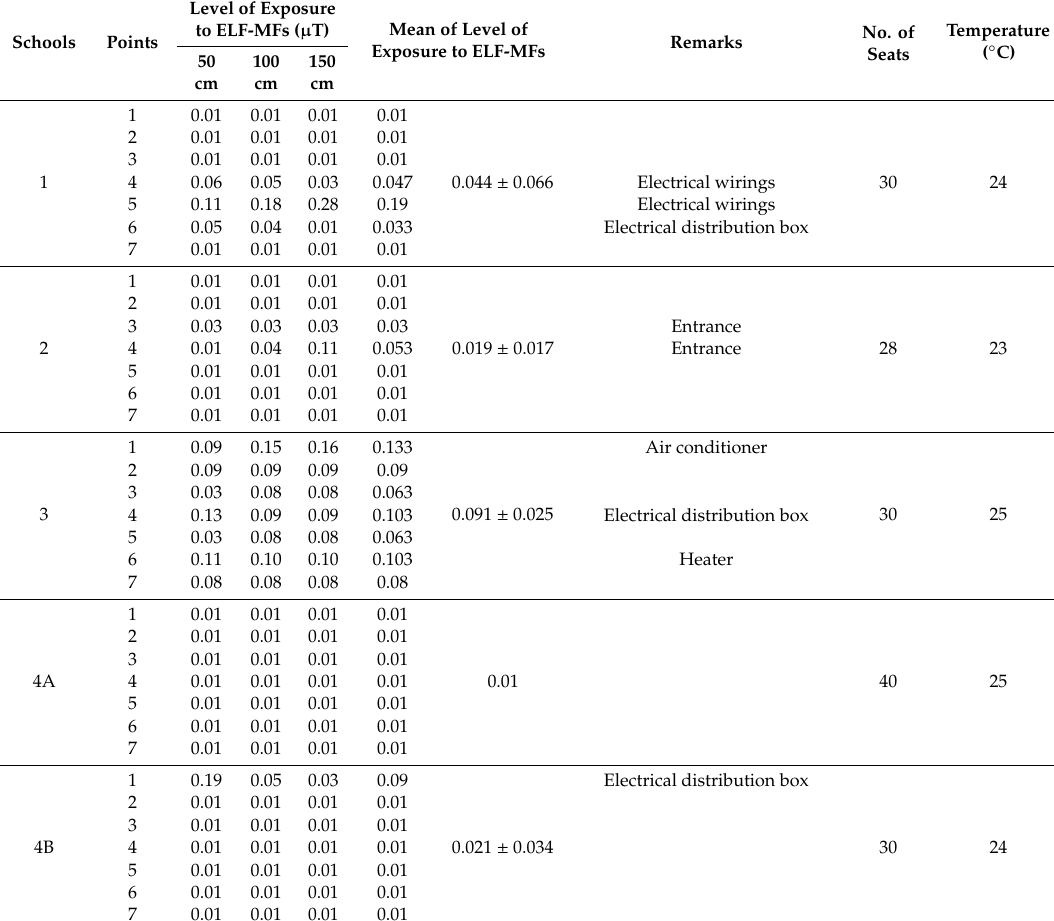
Table 1. Extremely low-frequency magnetic fields (ELF-MFs) exposure levels in the classrooms in each